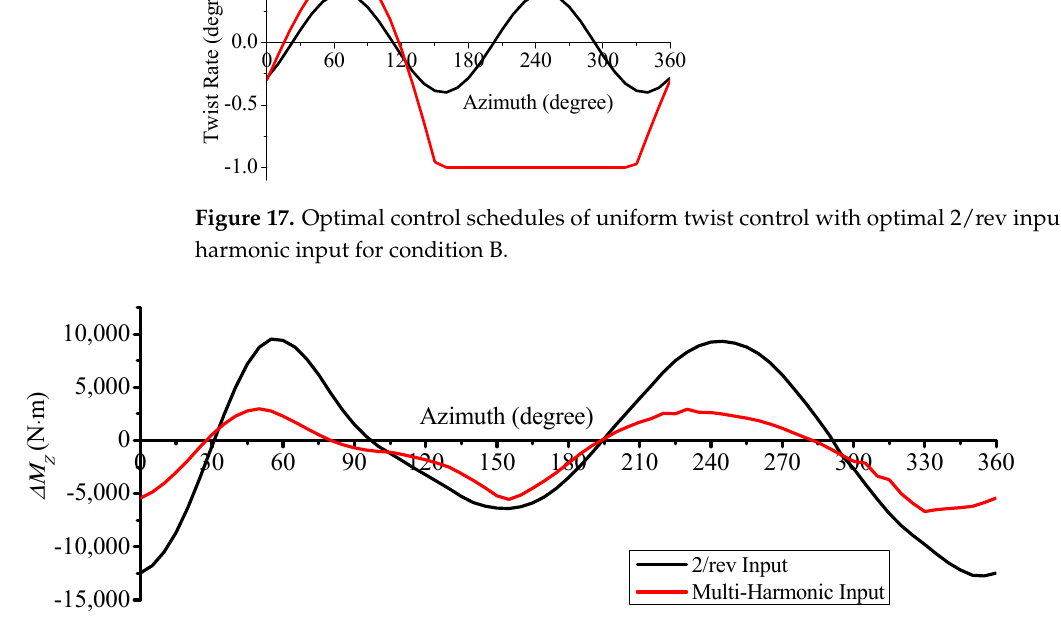
Figure 18. Blade shaft moment increments of uniform twist control with optimal 2/rev input and multi-harmonic input relative to the baseline rotor for condition B.